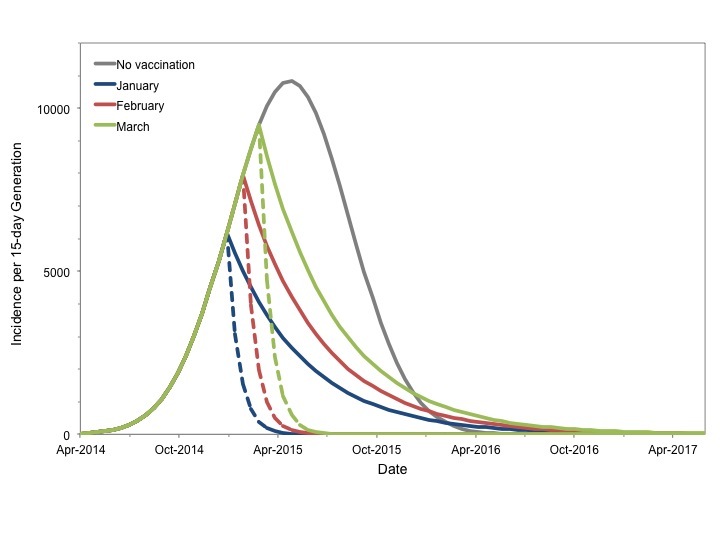
Epidemic curve projected for most likely scenario in the absence of vaccination is presented in grey. Hypothetical instantaneous vaccination sufficient to reduce Re to 0.9 (solid colored curves) or 0.5 (dashed curves) based on initiation in January (blue curve), February (red curves) or March 2015 (green curves) markedly changes projected course of the epidemic. Earlier and more intensive vaccination result in smaller final epidemic sizes.